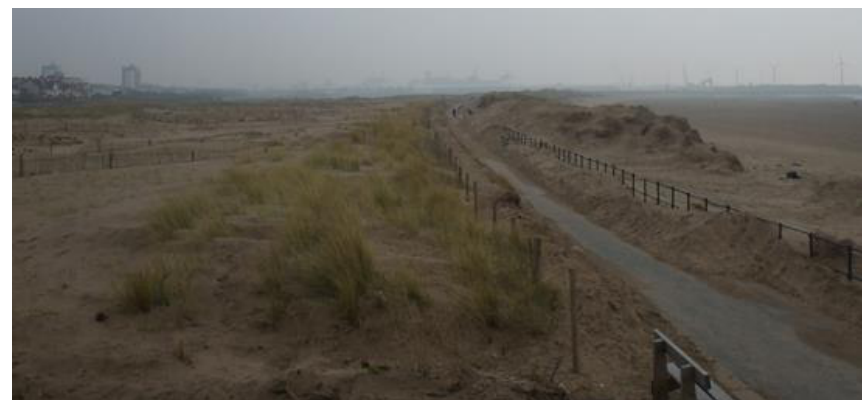
Figure 1. An example of a UK site (Crosby, North West England) where the dune system has built up around an engineered defence (the pathway runs along the top of a seawall and revetment) due to its position relative to the spring high-tide level, thereby changing the management issues in this location from flood risk to safe